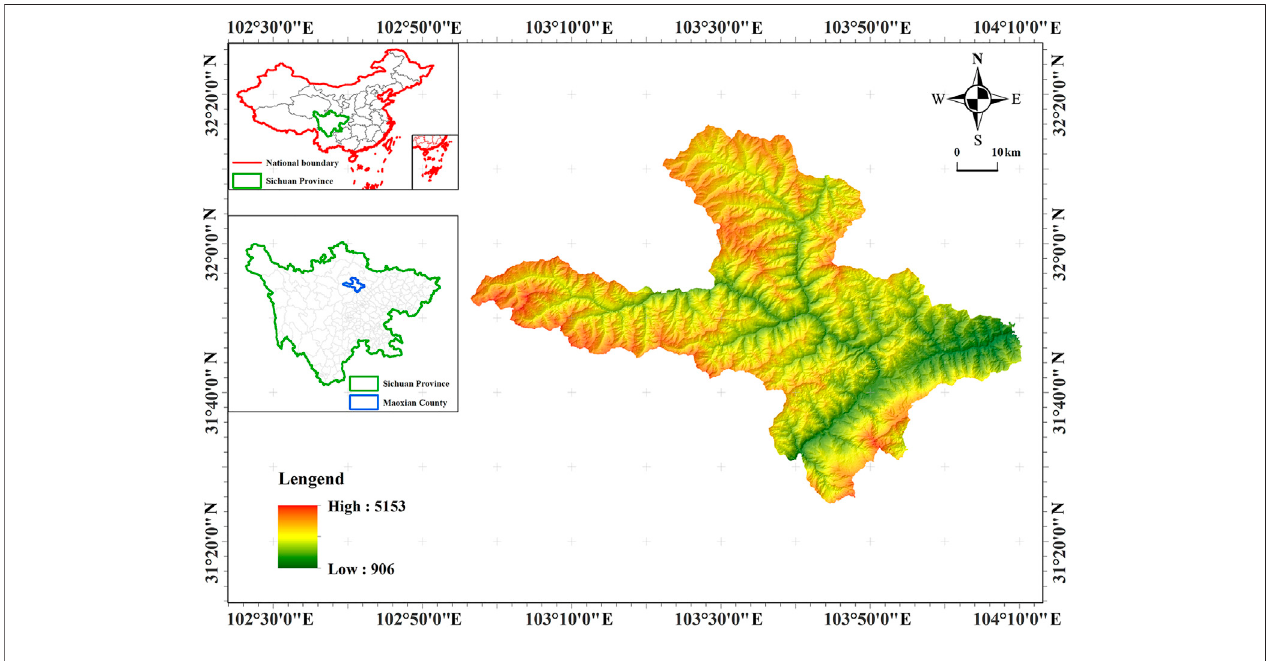
FIGURE 1 | Location of the study